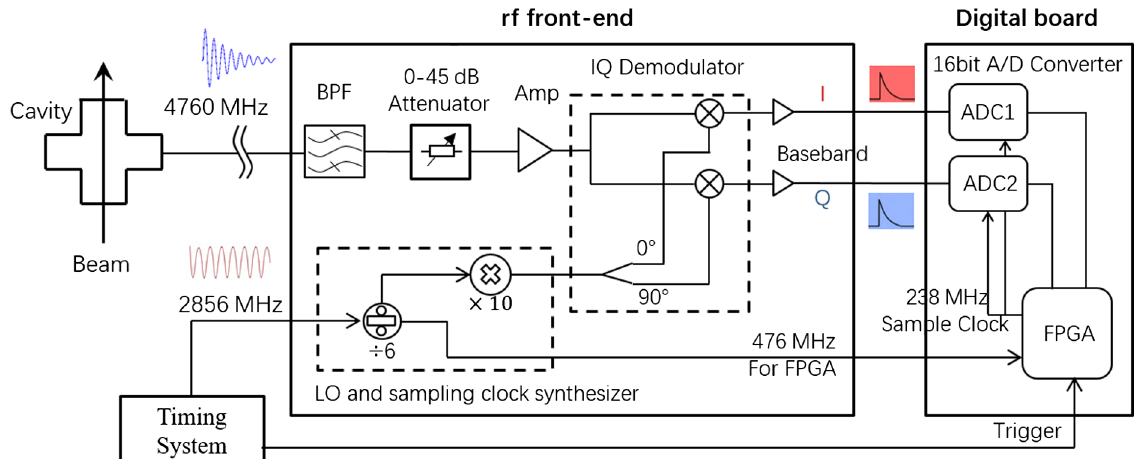
FIG. 7. Schematic diagram of the BAM